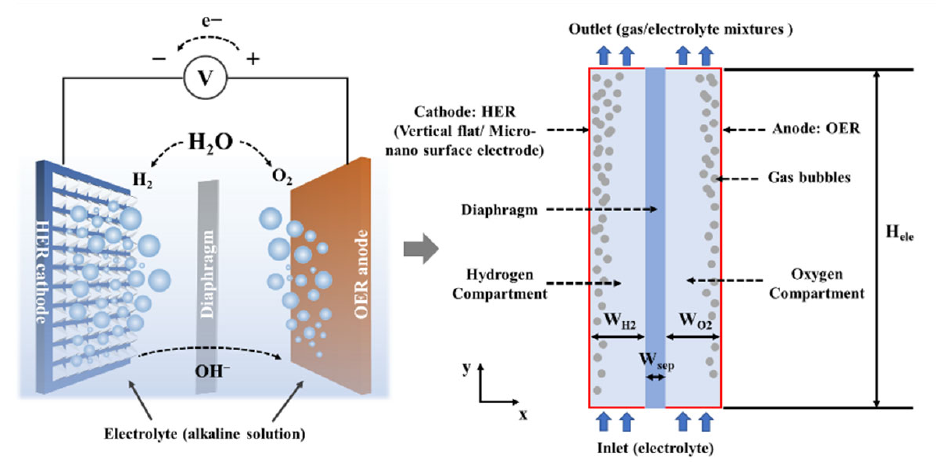
Figure 1. Schematic diagram of the 2D geometric model of AWE.